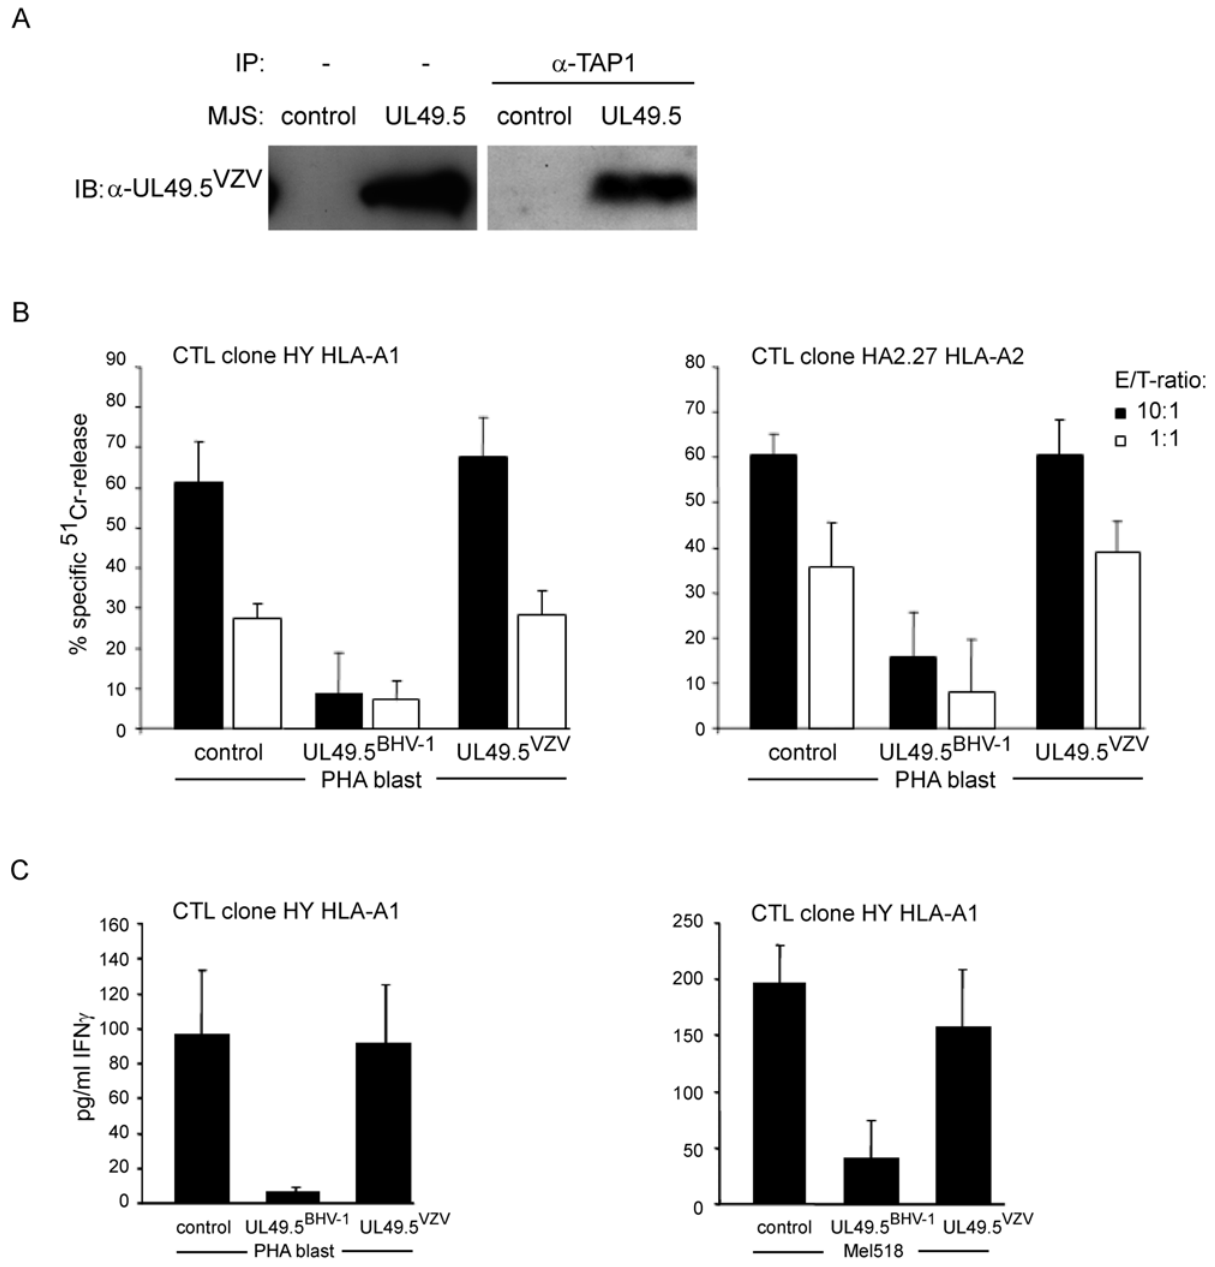
Figure 3. VZV UL49.5 interacts with the peptide-loading complex, but does not inhibit MHC class I-restricted T cell recognition. (A) TAP1 was immunoprecipitated (IP) from MJS cells expressing EHV-1 or VZV UL49.5 proteins. Co-precipitating UL49.5 proteins were analyzed by immunoblotting (IB) using antibodies against EHV-1 or VZV UL49.5. Left panel: cell lysates were loaded on SDS-PAGE directly and stained by immunoblotting. (B) BHV-1 or VZV UL49.5-expressing PHA-treated T-cell blasts were labeled with 51 Cr and used as target cells for CTL clones specific for the minor histocompatibility antigens HY and HA-2, recognized in the context of HLA-A1 and HLA-A2, respectively. Specific lysis was determined by measuring 51 Cr release from the target cells after 4 hrs. Effector/target (E/T) ratios are indicated. (C) PHA-treated T-cell blasts or a melanoma cell line (Mel518) carrying the HY antigen were incubated with the HY-specific CTL clone HY HLA-A1. IFN- c levels released by the CTL clones were determined from the supernatants of the co-cultures after 24